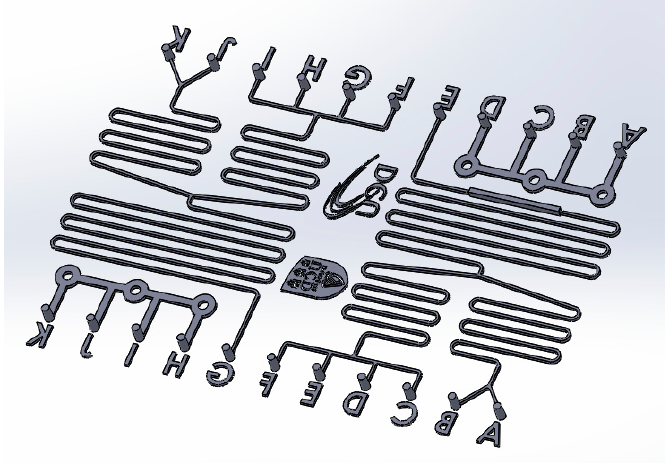
Figure 2. Microfluidic pattern design.